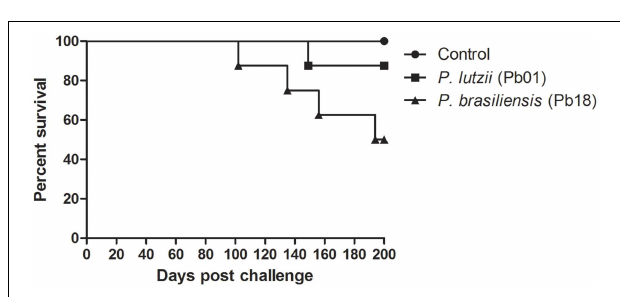
FIGURE 4 | Virulence of the genus Paracoccidioides . Survival curves of C57BL/6 mice infected with P. brasiliensis and P. lutzii observed for 200 days after infection, showing an increased ability of P. brasiliensis to kill mice, with a statistically significant difference relative to the control ( p < 0 . 05 ).